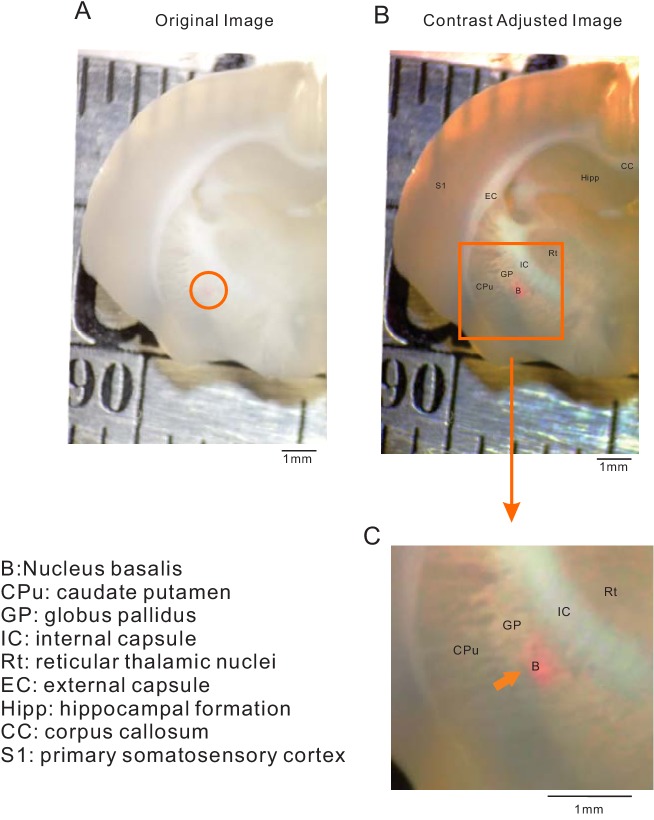
Calibration of stereotaxic coordinates used for AAV injections in NB.(A) Raw low-power brightfield stereomicroscopic image of coronal brain section (P21 rat) with DiI (1 mM) injection site (interaural 7.28 mm; bregma −1.72 mm in Paxinos and Watson (2006). Contrasted-enhanced version of image shown in A with superposition of corresponding landmark annotations. (C) Enlargements of the boxed region in B centered on the NB (circled region in A). Anatomical landmark abbreviations defined to the left of panel C. Calibration bars are 1 mm in each image.